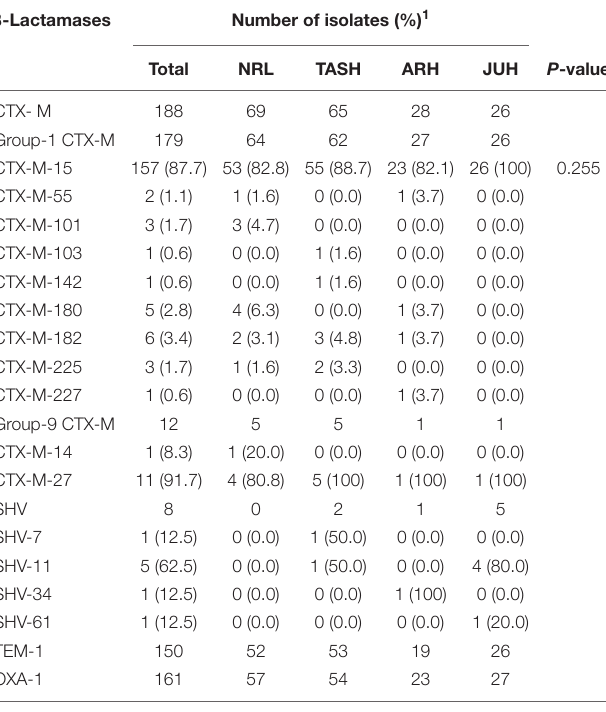
TABLE 2 | Type and distribution of β -lactamases detected among ESBL-producing E. coli isolates from the four health facilities. β -Lactamases